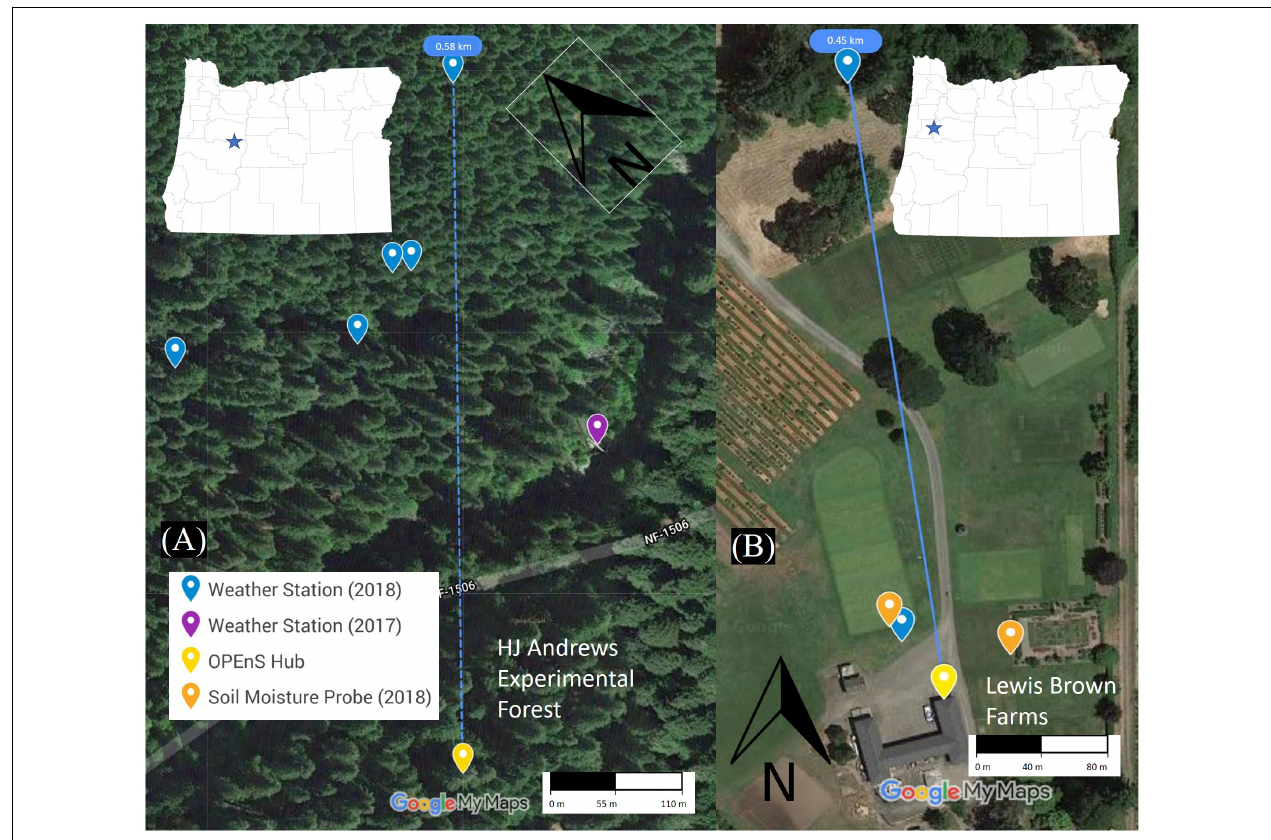
FIGURE 2 | Map of field site at H.J. Andrews Experimental Forest (A) and Lewis Brown Farms (B) , showing relative distances from nodes to Hub.